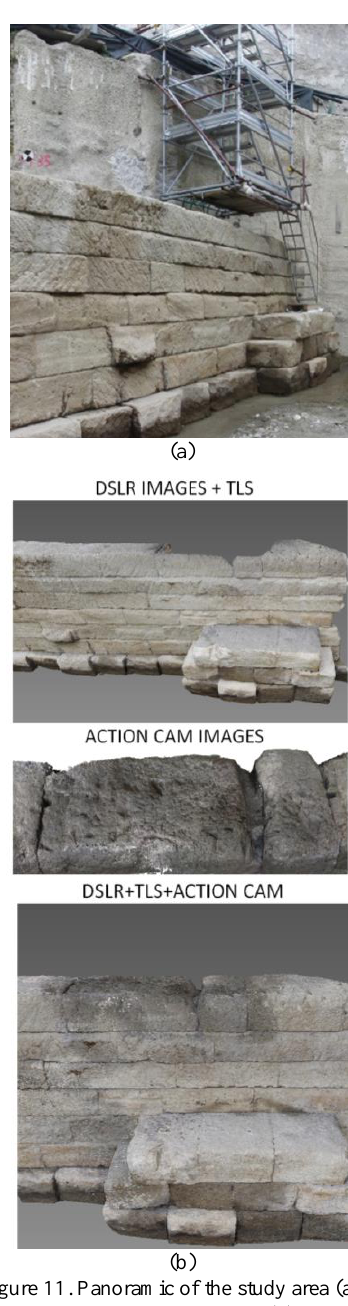
Figure 11. Panoramic of the study area (a) and point clouds models